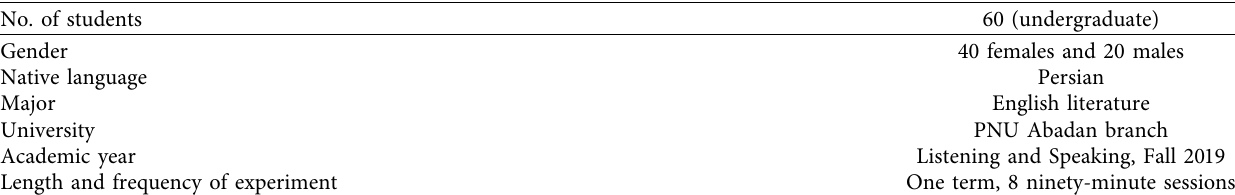
Table 1: Participants of the